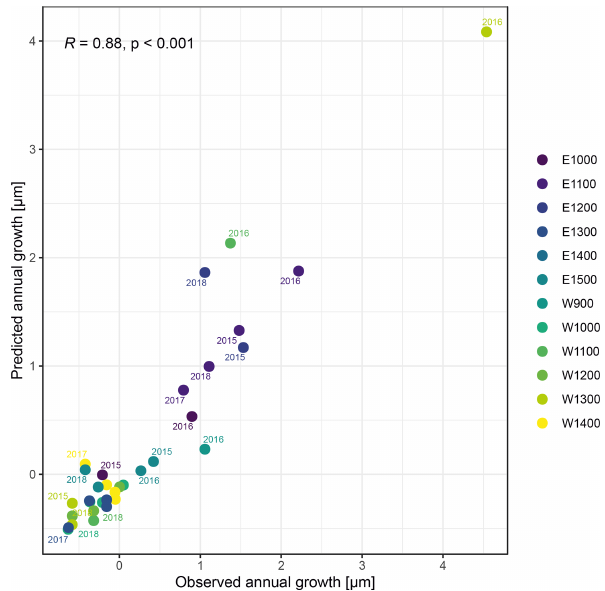
Figure A7. Observed annual growth and annual growth predicted by a linear regression model including timing (growth initiation and growth cessation), as well as peak growth as independent variables. Colors indicate the monitored specimens at the individual sites (E denotes east; W denotes west; numbers indicate elevation,